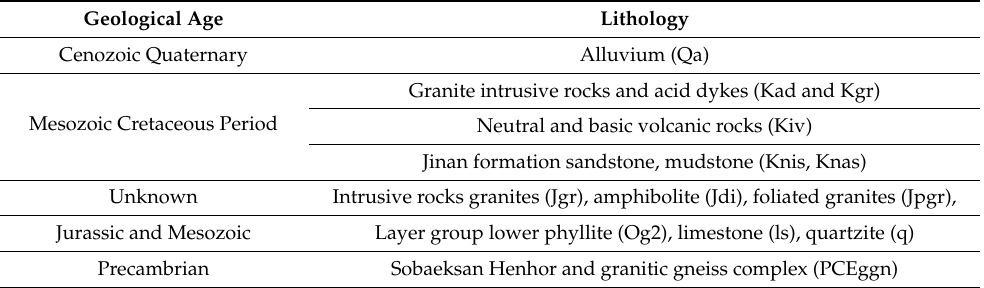
Table 1. Regional stratigraphic data.